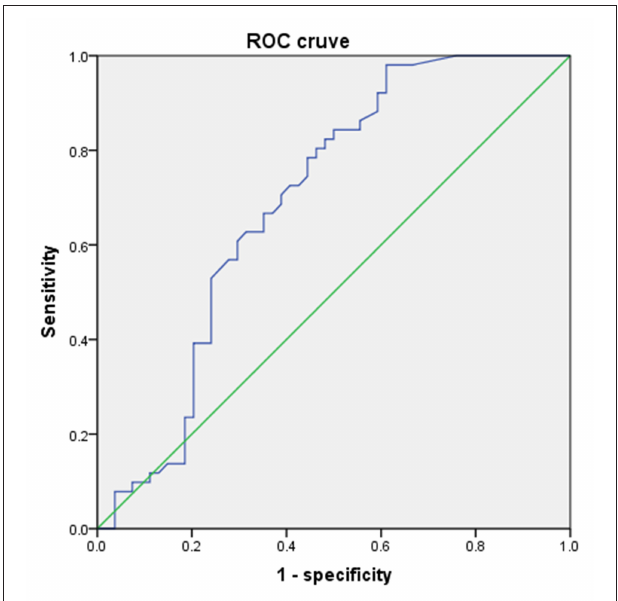
FIGURE 4 | The ROC curve of uric acid to predict puberty in males.